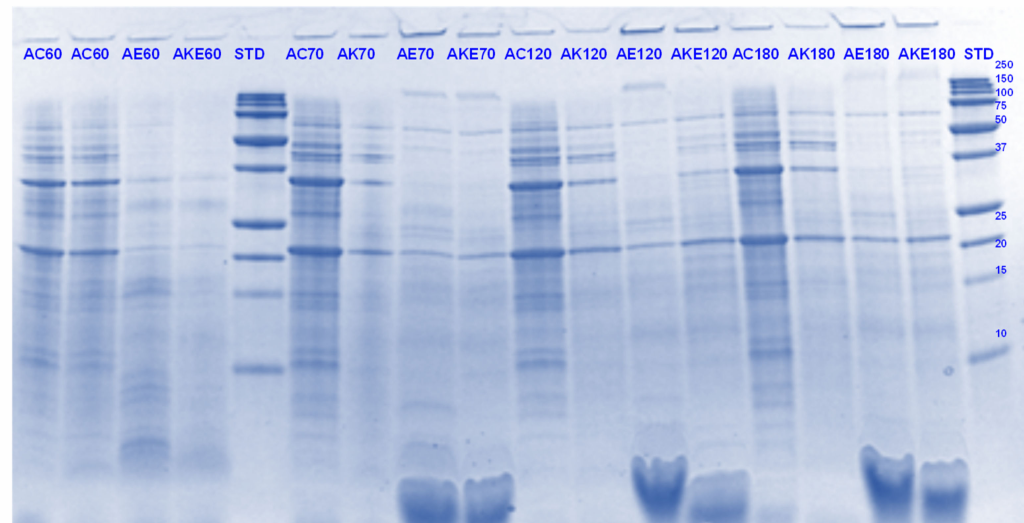
Figure 13. Tricine SDS-PAGE electrophoretogram of almond (A) digests after 60, 70, 120 and 180 min of simulated oral-gastric-small intestinal digestion in the presence or absence of Hayward (K) kiwifruit extract. AC, almond (A) control without any digestive enzymes; AK, with added green kiwifruit extract but no digestive enzymes; AE, with digestive enzymes but no added kiwifruit extract; AKE, with both digestive enzymes and green kiwifruit extract. The number 60 is the gastric digestion time following 2 min of oral digestion. Numbers 70, 120 and 180 are the total digestion times in oral-gastro-small intestinal digestion (including 60 min of gastric digestion). Bands (1–10) in the molecular weight standard lane correspond to molecular weights 250, 150, 100, 75, 50, 37, 25, 20, 15 and 10 kDa.